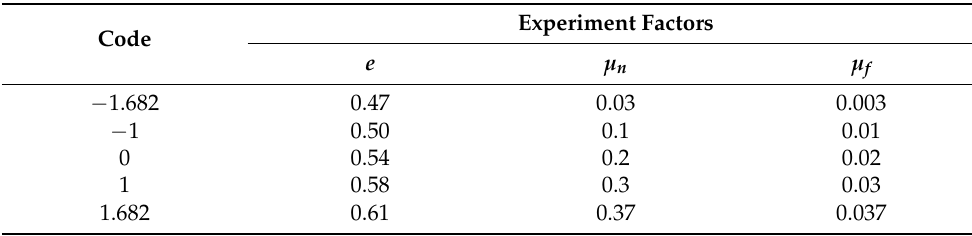
Table 12. Codes of simulation experiment factors.